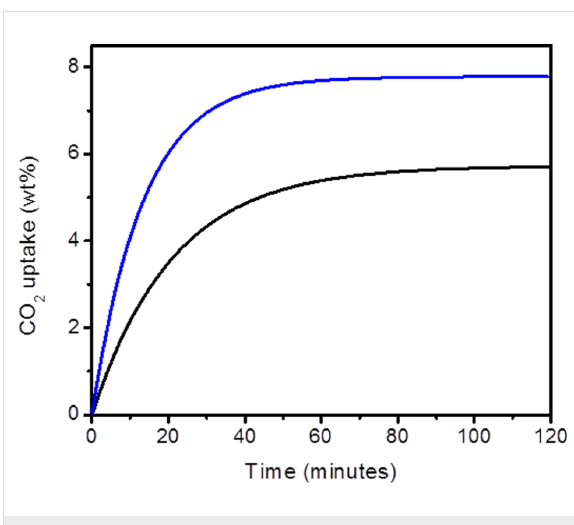
Figure 3: CO 2 uptake under moist conditions at 40 °C of COP-156 (black) and COP-156-amine (blue).